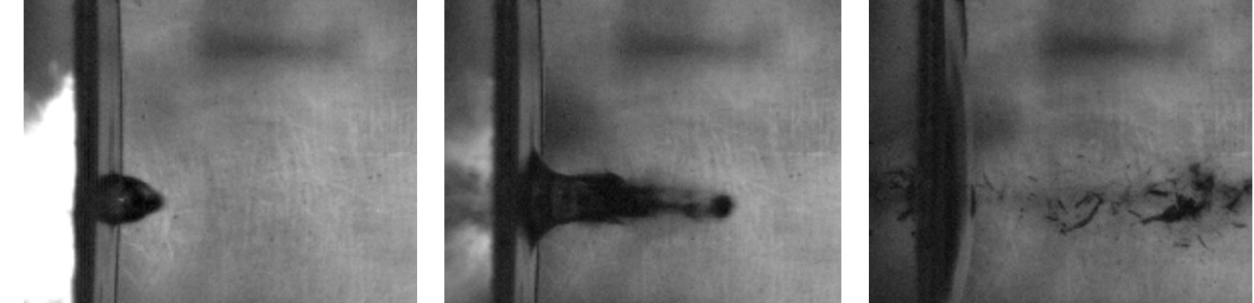
Figure 5. Frames from impact test video showing the panel’s self-healing capability.